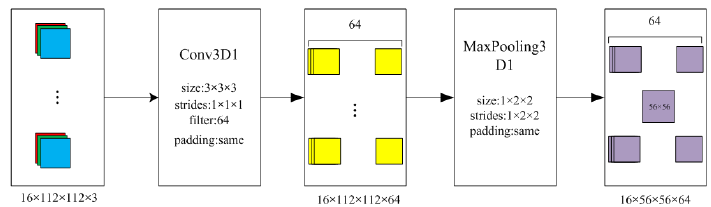
Figure 3. C3D (Convolutional 3D) neural network structure.